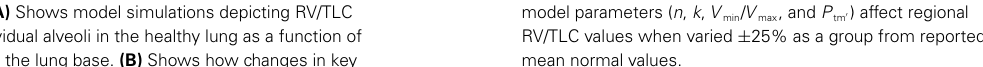
model parameters ( n , k , V min / V max , and P tm (cid:48) ) affect regional RV/TLC values when varied ± 25% as a group from reported mean normal